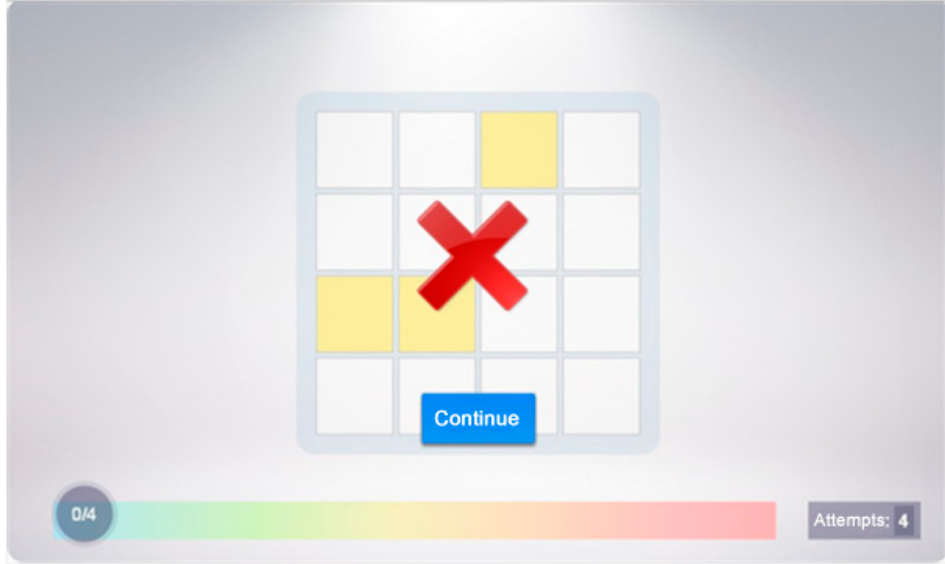
Figure 4. An example of a completed trial: the designation was performed incorrectly, and the correct location of the squares is shown to the participant (a screenshot from the software that we used in the experiment).